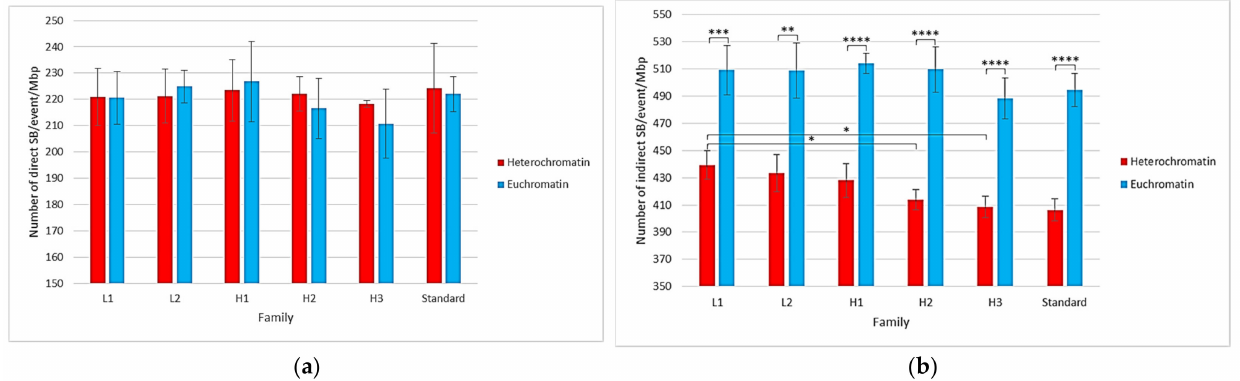
Figure 6. Comparison, for each type of voxel family, of the mean number and yield of ( a ) direct SBs/event/Mbp and ( b ) indirect SBs/event/Mbp. Error bars were obtained with five simulations. Asterisks above the bars represent the degree of confidence on the difference between the two related mean values assessed by Student’s t -test (* p < 0.05, ** p < 0.01, *** p < 0.001, **** p <